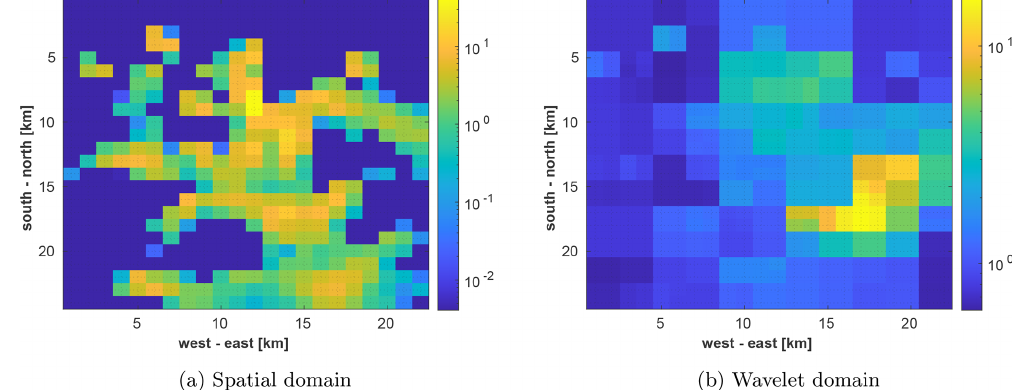
≈ 1 . 5 and an SNR of 20dB for SR in the (a) spatial domain and n